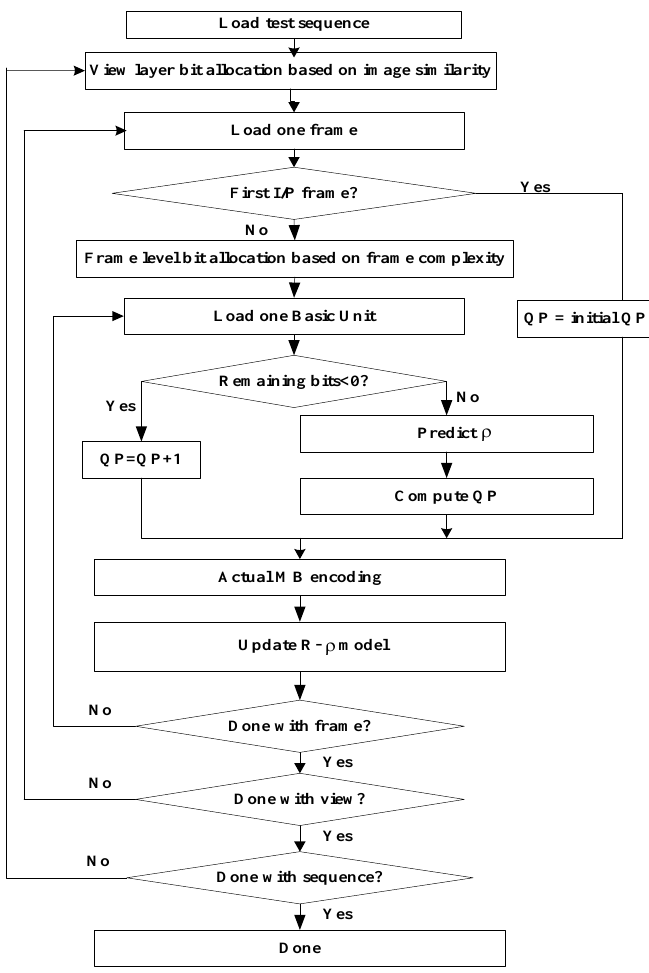
Figure 2. Rate control algorithm based on ρ model for